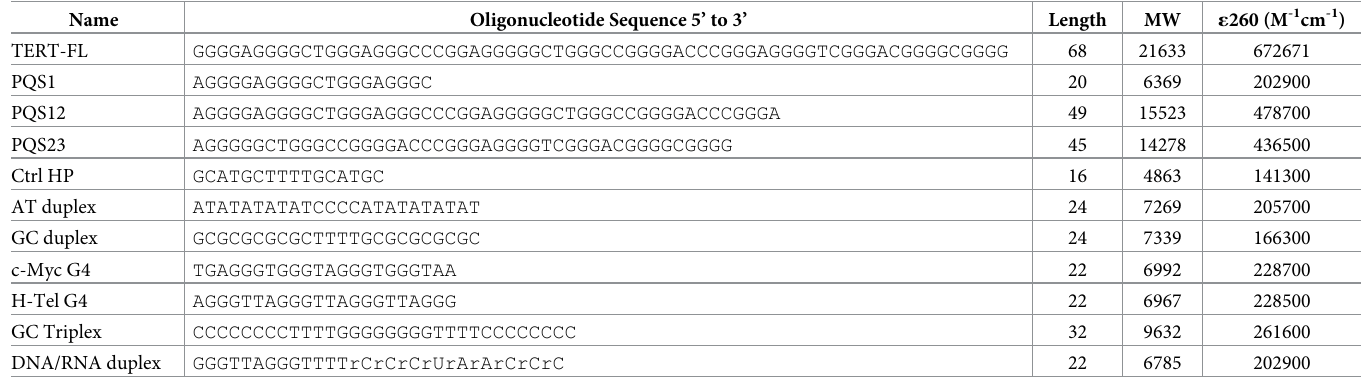
Table 1. Oligonucleotides used throughout this